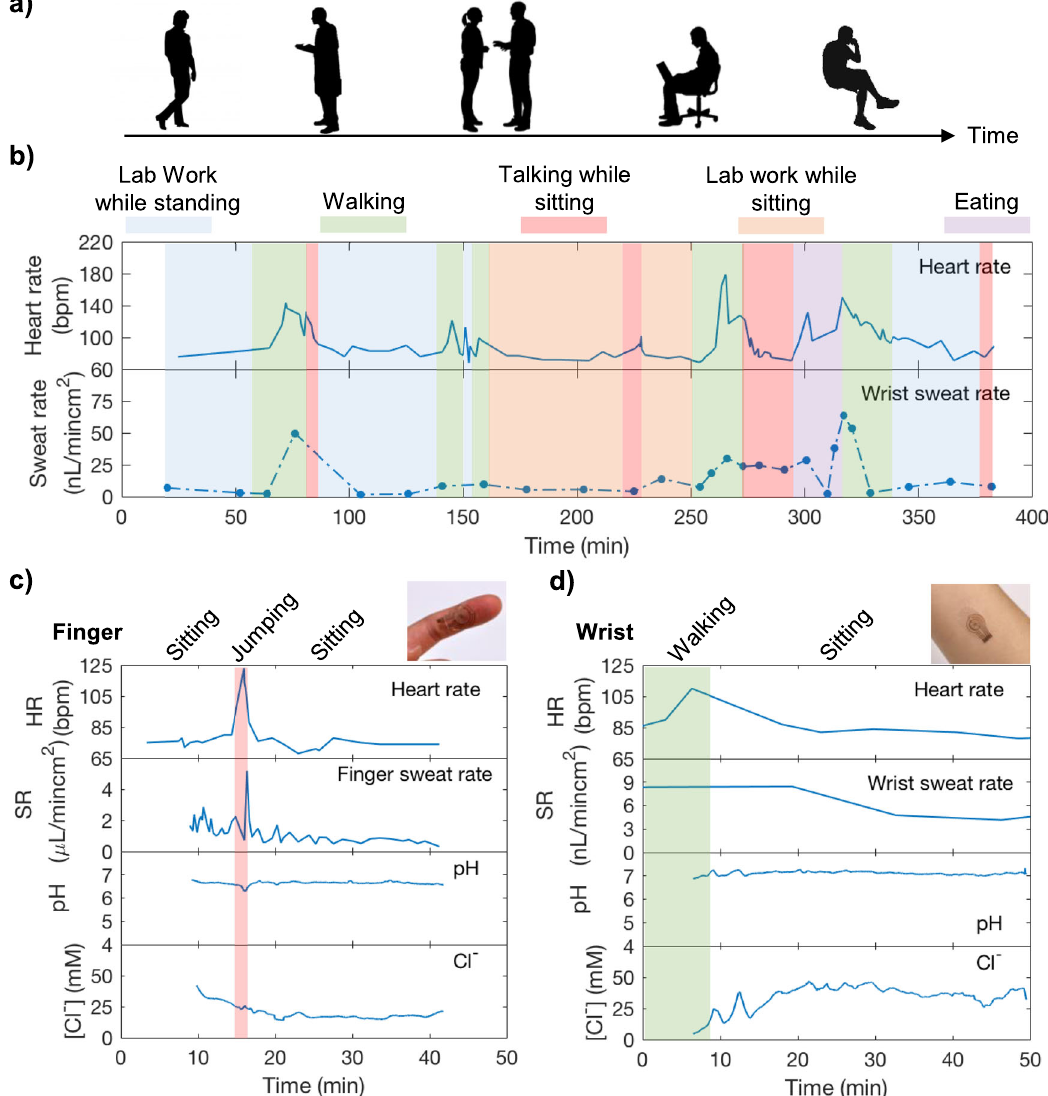
Fig. 4 In-situ sweat analysis of a healthy volunteer while performing daily tasks. a The study was conducted to explore dynamic heart rate and sweat behaviors of a sedentary subject during routine activities such as talking, walking, eating, etc. b A subject wore the micro fl uidic patch and a heart rate monitor on the wrist, and heart rate and sweat rate were continuously monitored for 6 h. A subject wore the micro fl uidic patch on ( c ) fi nger and ( d ) wrist, and heart rate, sweat rate, sweat pH and Cl − were simultaneously measured. Sweat measurement began 10 min and 4 h after sweat secretion began on fi nger and wrist, fi nger and wrist sweat analyses 10 min and 4 h after sweat secreted into the sensing channel. The time scales were chosen based on the subjects ’ average sweat rate shown in Supplementary Table 2 and to achieve a stable sensing signal. For instance, for an average sweat rate of 300 nL min − 1 cm − 2 , it takes ~3 min for sweat to fl ow into the sensing channel. To ensure we can capture a stable signal we waited until 10 min to initiate the measurement.